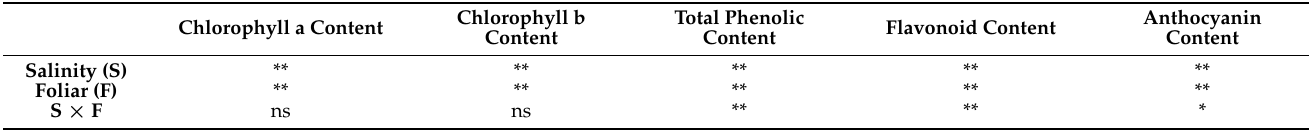
Table 5. ANOVA for the effect of salinity (0–50 and 100 mM NaCl) and foliar applications (no spray, salicylic acid, CeO 2 -nanoparticles, and CeO 2 : SA-nanoparticles) on the content of chlorophylls, total phenolics, flavonoids, and anthocyanins in Portulaca oleracea plants. Chlorophyll a